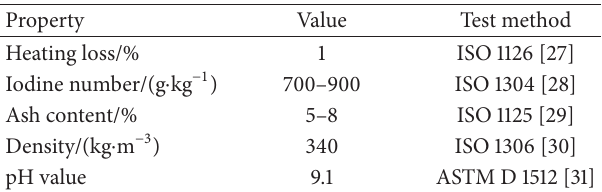
Table 1: The properties of Carbon Black. Property Value Test